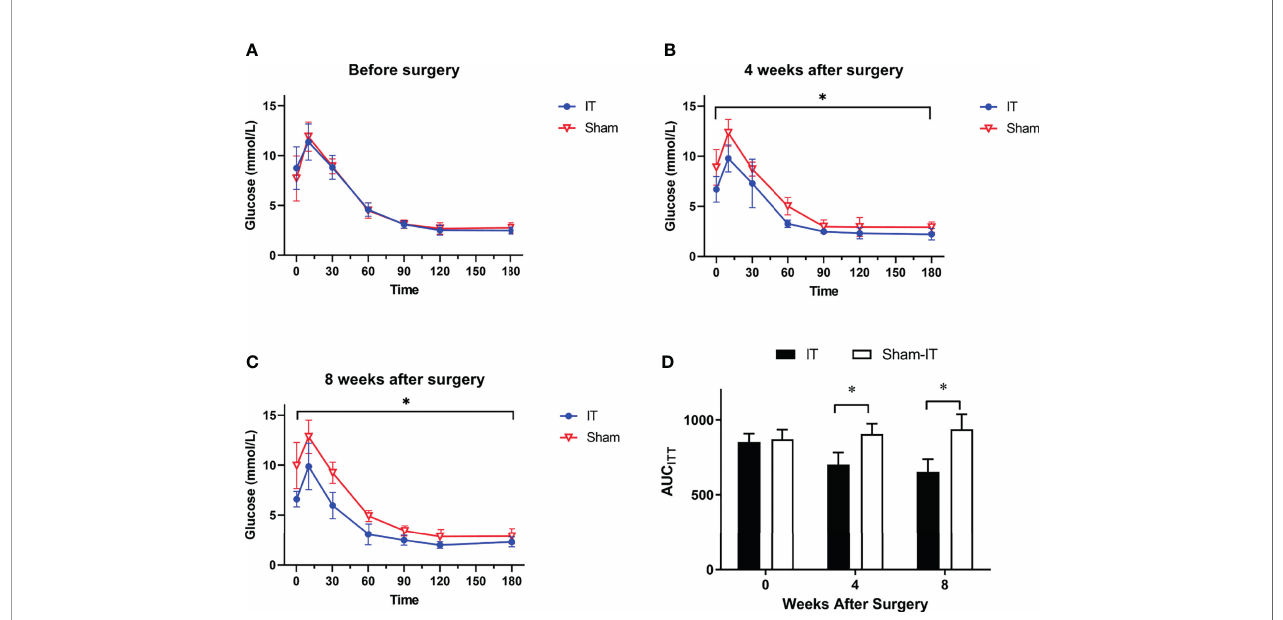
FIGURE 4 | ITT results at different time points. N = 6 in each group. * p < 0.05. (A) ITT before surgery. No difference was found between groups (two-way ANOVA: p = 0.993). (B) ITT at 4 weeks after surgery. IT rats showed signi fi cantly improved ITT as compared with sham rats (two-way ANOVA: p = 0.001). (C) ITT at 8 weeks after surgery. ITT data of IT rats was signi fi cantly better than sham (two-way ANOVA: p < 0.001). (D) AUC ITT . No difference was observed in AUC ITT between IT and sham groups before operation ( t -test, p = 0.605). At postoperative 4 weeks, AUC ITT were signi fi cantly decreased in IT group ( t -test, p = 0.001). At 8 weeks postoperatively, the difference became more signi fi cant ( t -test, p <